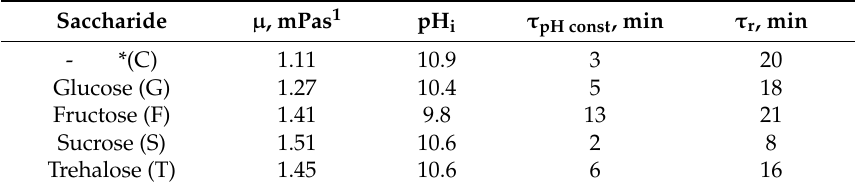
Table 1. Summary of precipitation conditions: the viscosity of initial solution ( µ ), the initial pH (pH i ), the time period of constant pH ( τ pH const ), the time of reaction ( τ r